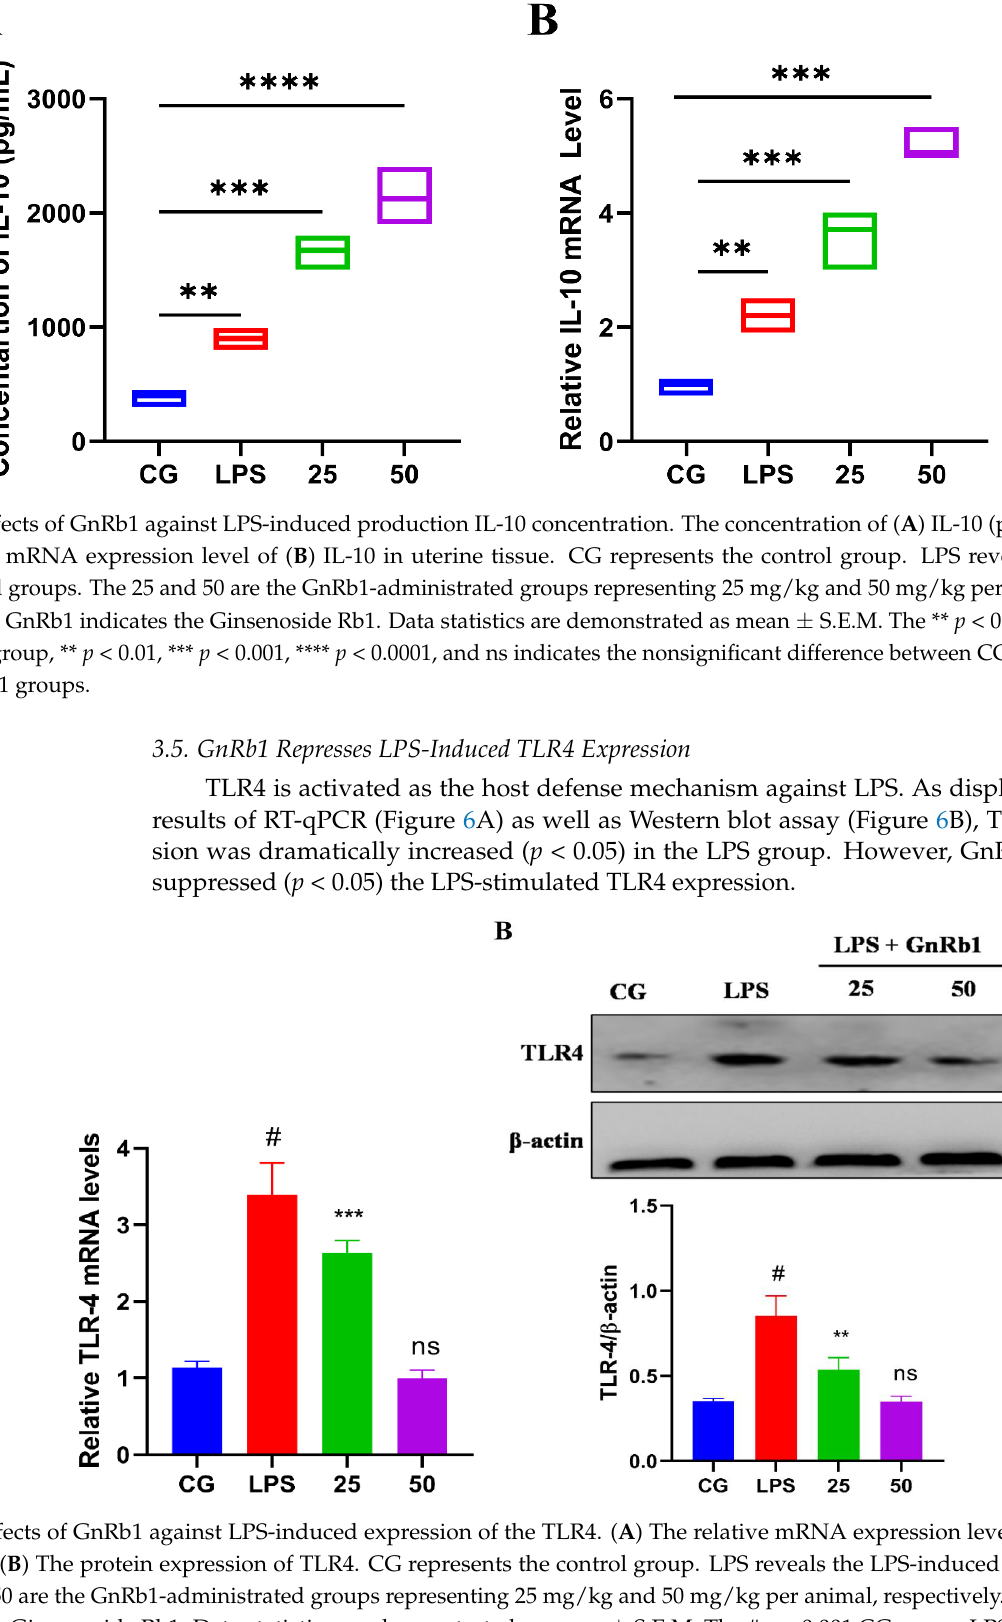
Figure 6. Effects of GnRb1 against LPS-induced expression of the TLR4. ( A ) The relative mRNA expression level of the TLR4 gene. ( B ) The protein expression of TLR4. CG represents the control group. LPS reveals the LPS-induced groups. The 25 and 50 are the GnRb1-administrated groups representing 25 mg/kg and 50 mg/kg per animal, respectively. GnRb1 indicates the Ginsenoside Rb1. Data statistics are demonstrated as mean ± S.E.M. The # p < 0.001 CG versus LPS group, ** p < 0.01, *** p < 0.001, and ns indicates the nonsignificant difference between CG versus LPS + GnRb1 groups.